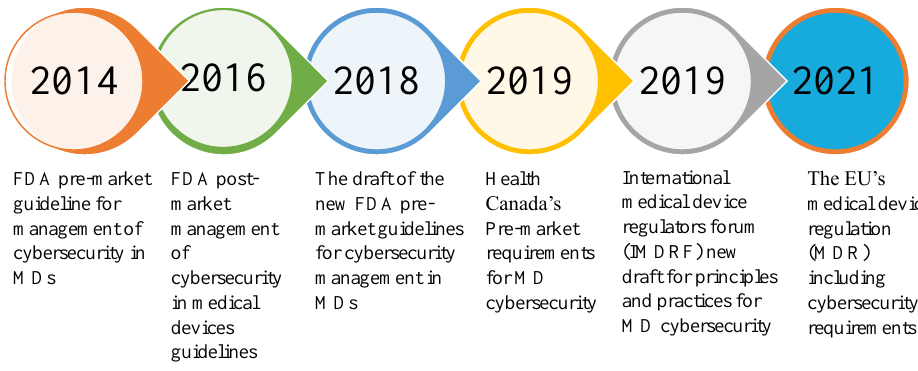
Figure 7. Evolution of medical device cybersecurity